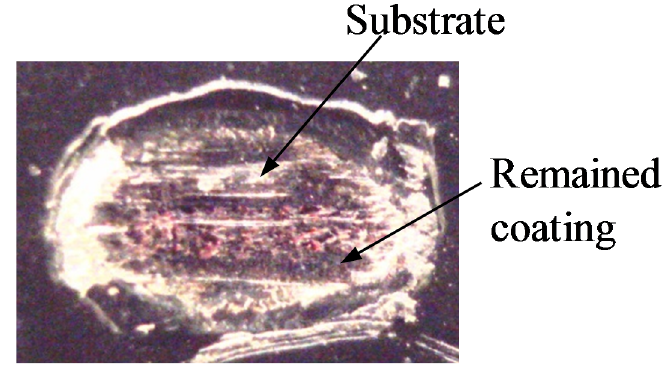
Figure 4. Worn surface image at the friction coefficient of 0.5: An electro-deposited coating against a conventional